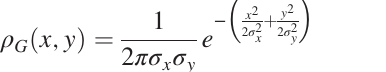
FIG. 2. Left: Sketch of the principle of the standard method to measure DA. Right: Measured and simulated losses (from Ref.